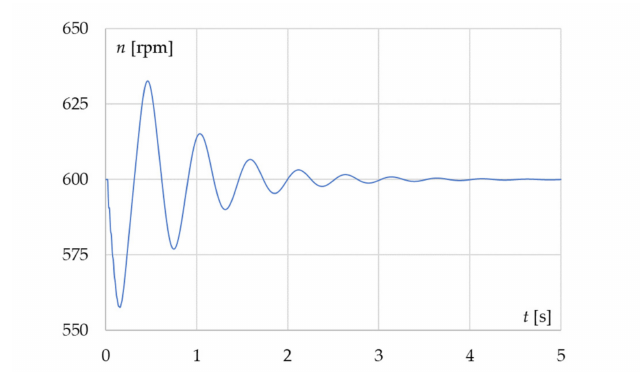
Figure 12. Waveform of speed during out-of-phase synchronization of − 120 ◦ .